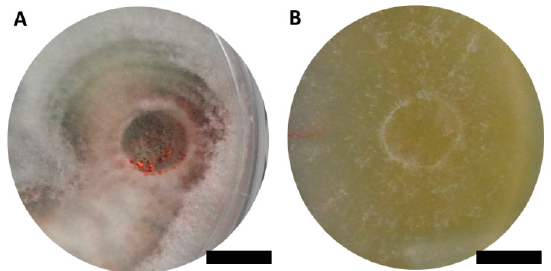
Figure 1. Colony appearances of ( A ) Talaromyces apiculatus (Ta) AAT0115 and ( B ) Clonostachys rosea (Cr) AAB0114 on malt extract agar incubated for 7 days. Scale bar: 10 mm.